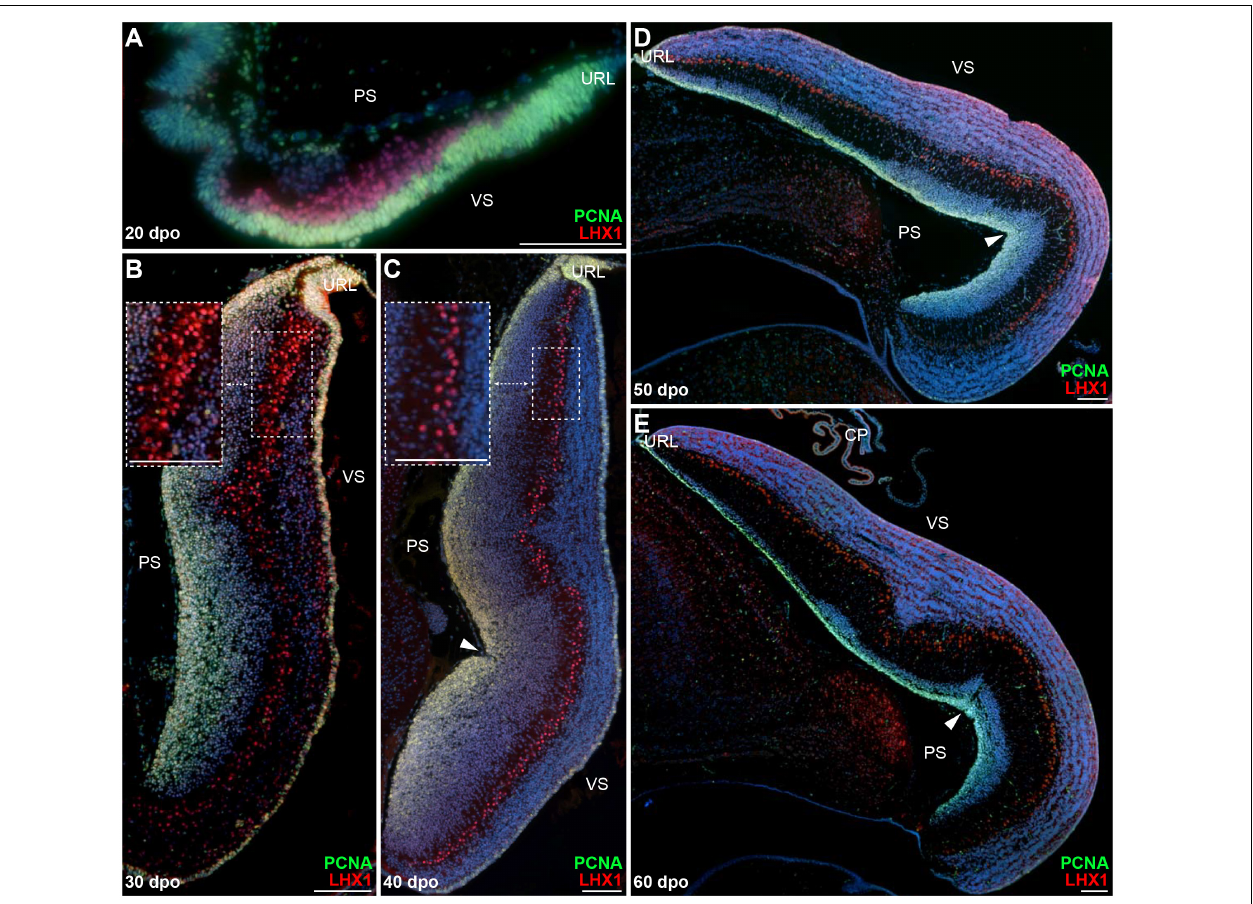
FIGURE 2 | Proliferation pattern and PC development in embryonic P. vitticeps cerebellum. (A–E) Double immunohistochemistry (IHC) staining for PCNA (green staining) and LHX1 (red) markers at various developmental stages, indicated as embryonic days post-oviposition (dpo), in the cerebellum of P. vitticeps . Arrowheads in panels (C–E) indicate the position of the incomplete fissure on the cerebellar pial surface. Insets in panels (B,C) show high magnifications of PC spatial organization. PS, pial surface; VS, ventricular surface; URL, upper rhombic lip. Scale bars: 100 µ